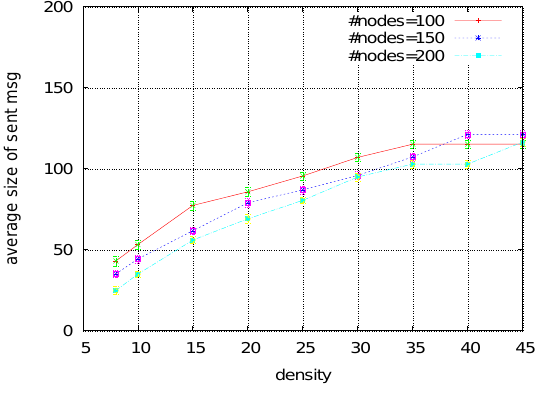
Fig. 6. Average number of bytes sent per